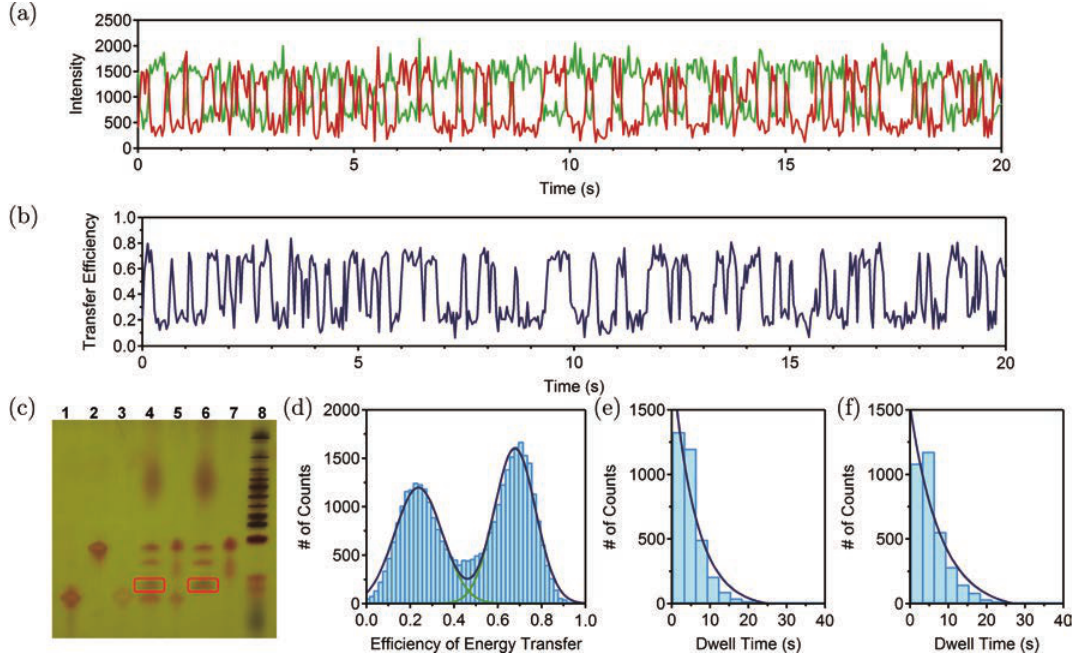
Fig. 3. (Color online) (a) Typical traces of digested BamHI – HJ. Green and red traces refer to Cy3 and Cy5 signals, respectively. (b) The time trajectory of the FRET e±ciency. (c) The denatured PAGE results of BamHI digestion of HJ. Lane 1: h-strand, lane 2: r-strand, lane 3: biotin strand, lane 4: BamHI – HJ digested by BamHI, lane 5: BamHI – HJ only, lane 6: the complex of r-strand and x-strand digested by BamHI, lane 7: complex of r-strand and x-strand only and lane 8: low molecular weight DNA ladder (N3233L, New England BioLabs). (d) The e±ciency of energy transfer distribution of BamHI – HJ after BamHI digestion. Green curves are Gaussian ¯ttings to the two peaks and dark blue curve is the sum of the two Gaussian ¯tting curves. (e) The histogram for the dwell time at the \ isoII " state. Dark blue curve is the exponential ¯tting. (f) The histogram for the dwell time at the \ isoI " state. Dark blue curve is exponential ¯tting. The data in panels (a), (b) and (d) – (f) were collected after the digestion of